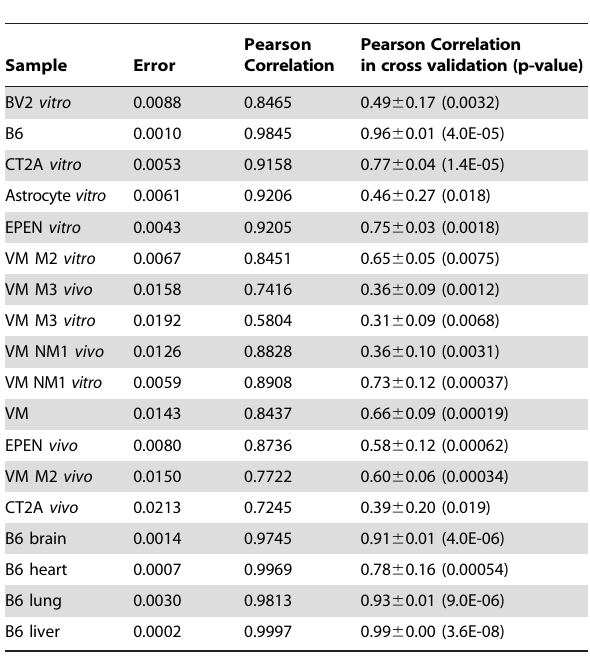
Table 1. The independent and identical distribution model successfully predicts CL distributions.